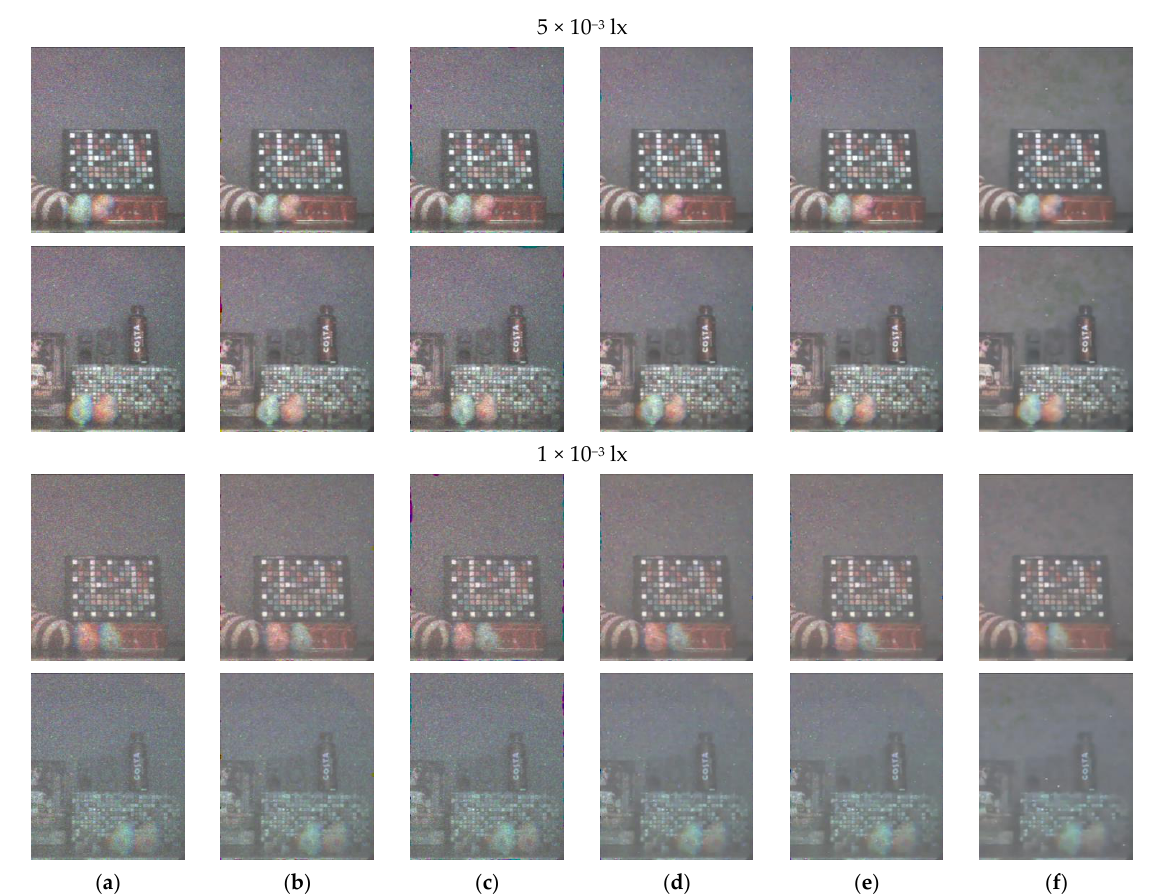
Figure 11. Results using real noisy data under different illuminant levels, with scene 1 on the top row and scene 2 on the bottom row: ( a ) noisy input; ( b ) CBM3D + FE; ( c ) DnCNN + FE; ( d ) fDnCNN + FE; ( e ) FFDNet + FE; ( f ) proposed DKPNN. Table 4. Evaluation metrics for each algorithm under different illuminant levels.